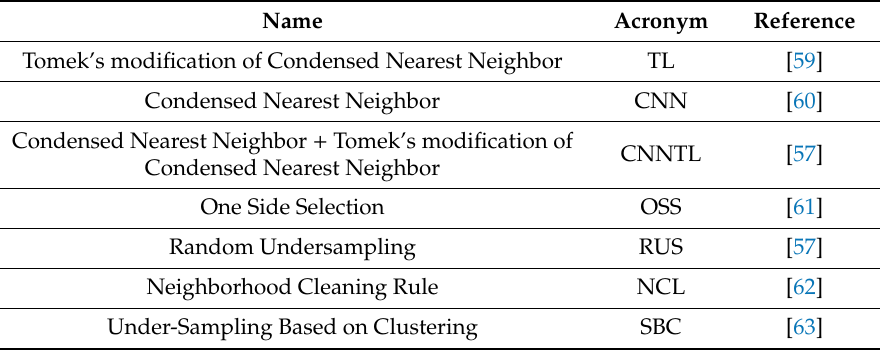
Table 4. Undersampling algorithms used.